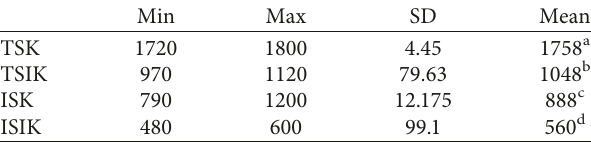
Table 1: Acrylamide content in Kolompehs ( μ g/kg).